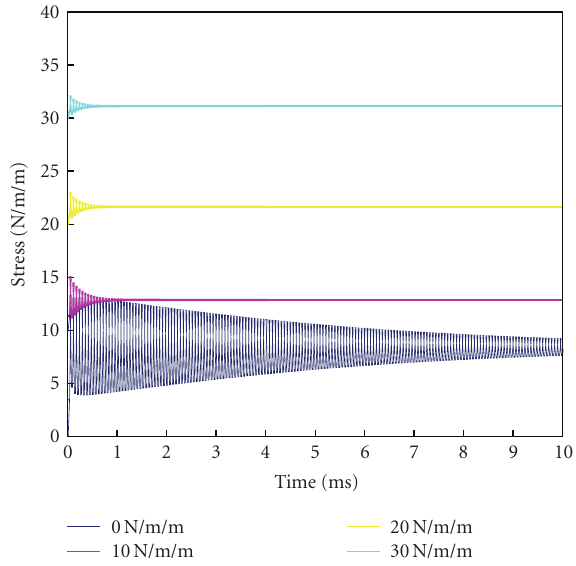
Figure 5: Stresses near the middle of an electrostatic fixed-fixed actuator for various residual stresses.